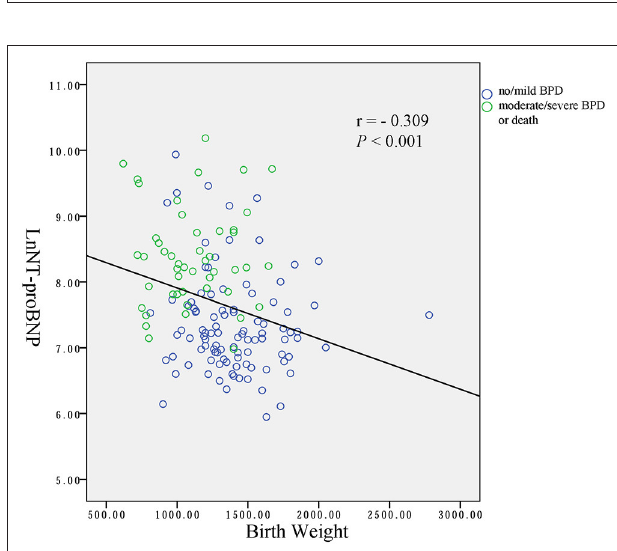
FIGURE 3 | Correlation between natural logarithms of serum NT-proBNP level and birth